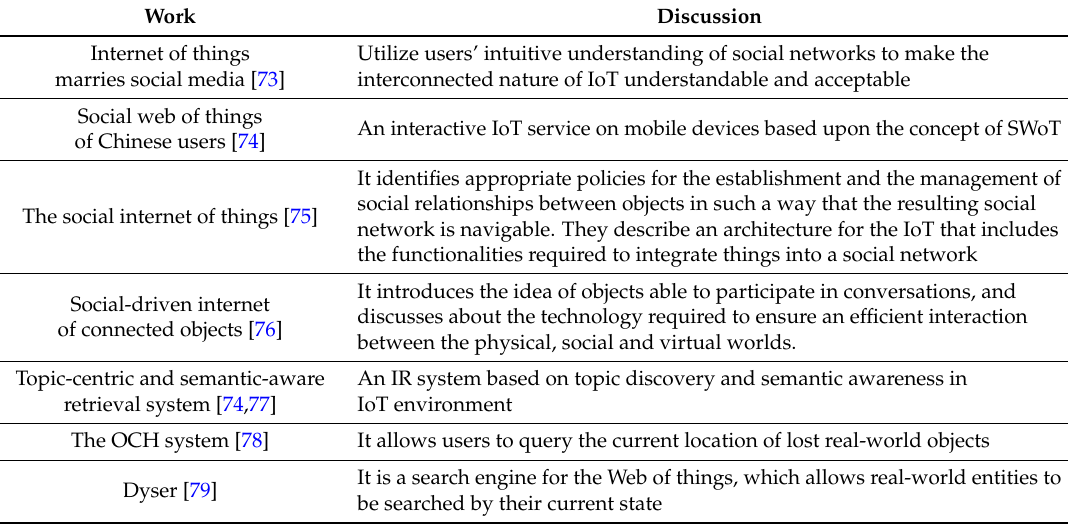
Table 3. Recent work on Context Aware